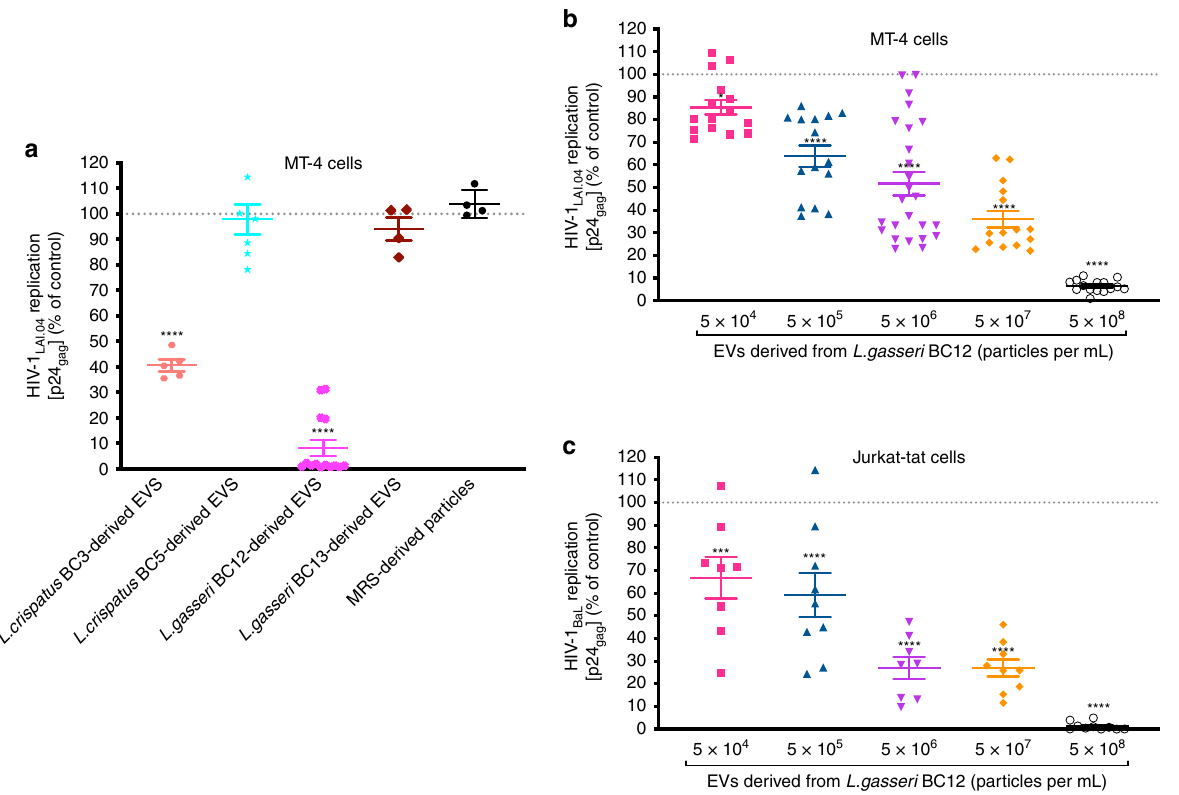
EVs derived from L.gasseri BC12 (particles per Fig. 2 Antiviral activity of Lactobacillus -derived EVs in human T cells. A mixture of HIV-1 LAI.04 or HIV-1 BaL and Lactobacillus -derived EVs incubated for 1 h was added to MT-4 or Jurkat-tat cell cultures for 1 h. Cells were washed and cultured for 3 days in the presence of EVs. In control experiments, EV-free and particles isolated from fresh MRS medium were tested as well. Replication of HIV-1 was evaluated by measuring the capsid protein p24 gag , in the cell culture medium; data are presented as percentages of HIV-1 replication in untreated controls. a The effects of bacterial-derived EVs (5 × 10 8 particles per mL) from L. crispatus BC3, L crispatus BC5, L. gasseri BC12, and L. gasseri BC13, and of particles isolated from MRS medium (3.87 × 10 8 particles per mL), on HIV-1 LAI.04 replication in MT-4 cells. b , c Concentration dependence of EVs derived from L. gasseri BC12 on replication of HIV-1 LAI.04 in MT-4 ( b ) and of HIV-1 BaL in Jurkat-tat ( c ) cell lines. Presented are means ± SEM from at least four independent measurements. Asterisks indicate statistical signi fi cance by one-way ANOVA multiple comparison with Dunnett ’ s correction (* p < 0.05, *** p < 0.001, **** p < 0.0001). Source data are provided as a Source Data fi